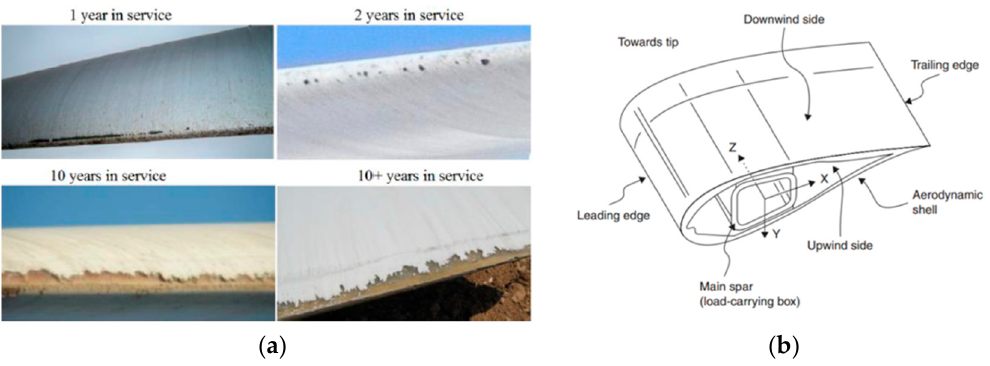
Figure 2. ( a ) Examples of leading edge erosion across a range of years in service [13]; ( b ) blade section with leading edge location where the rain erosion protection is critical.